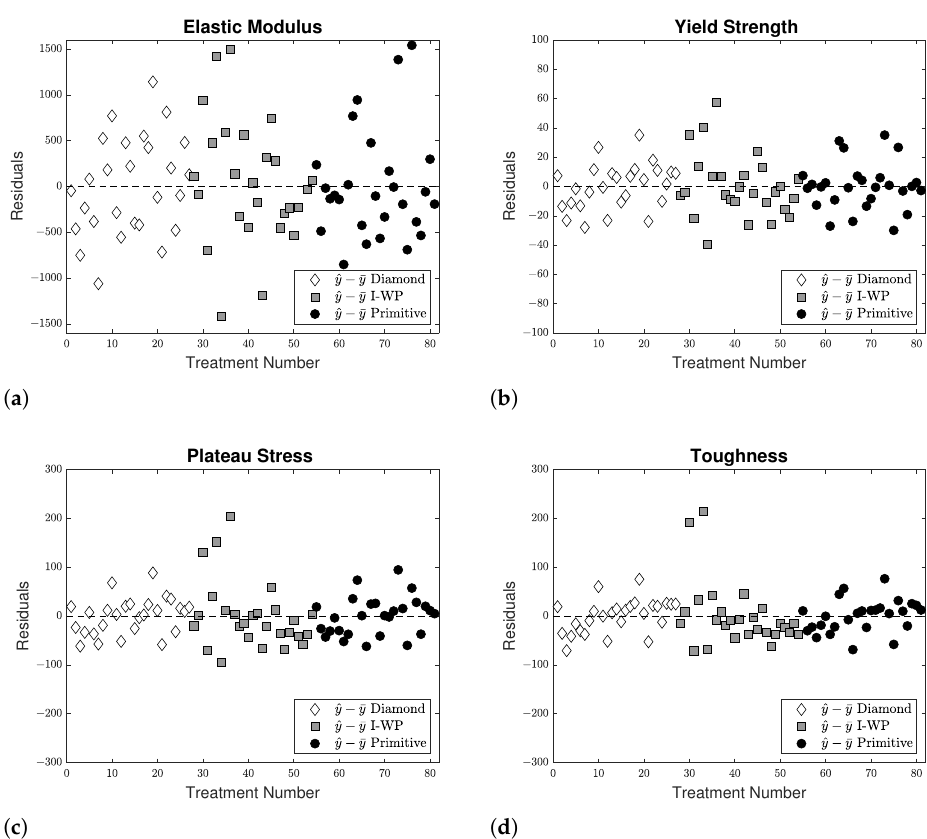
Figure 10. Residuals plotted against treatment number for: ( a ) elastic modulus, ( b ) yield strength, ( c ) plateau stress, ( d ) toughness.